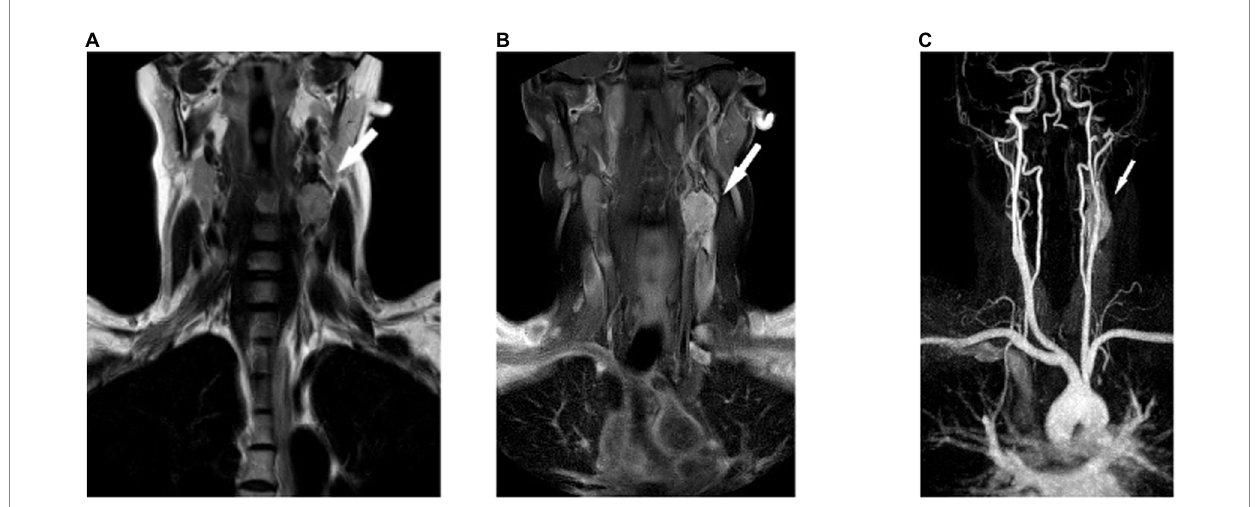
FIGURE 1 Carotid body tumor on the left side. (A) MR T2-weighted coronal image. (B) MR T1-weighted coronal image with fat suppression after contrast medium administration. (C) Contrast-enhanced MR angiography (CE-MRA), and maximum intensity projection (MIP) reconstruction in the coronal plane.